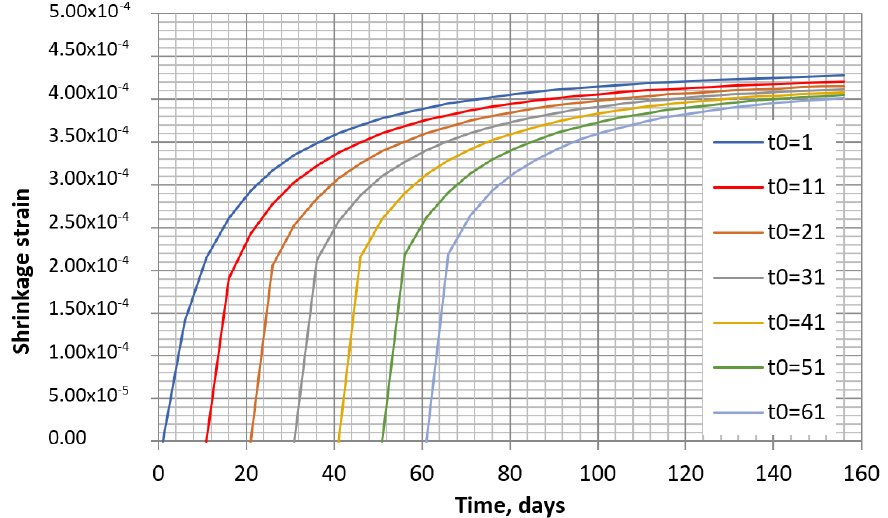
Figure 10. Shrinkage of concrete specimens according to B4 model at the different drying start times when humidity is 70%.